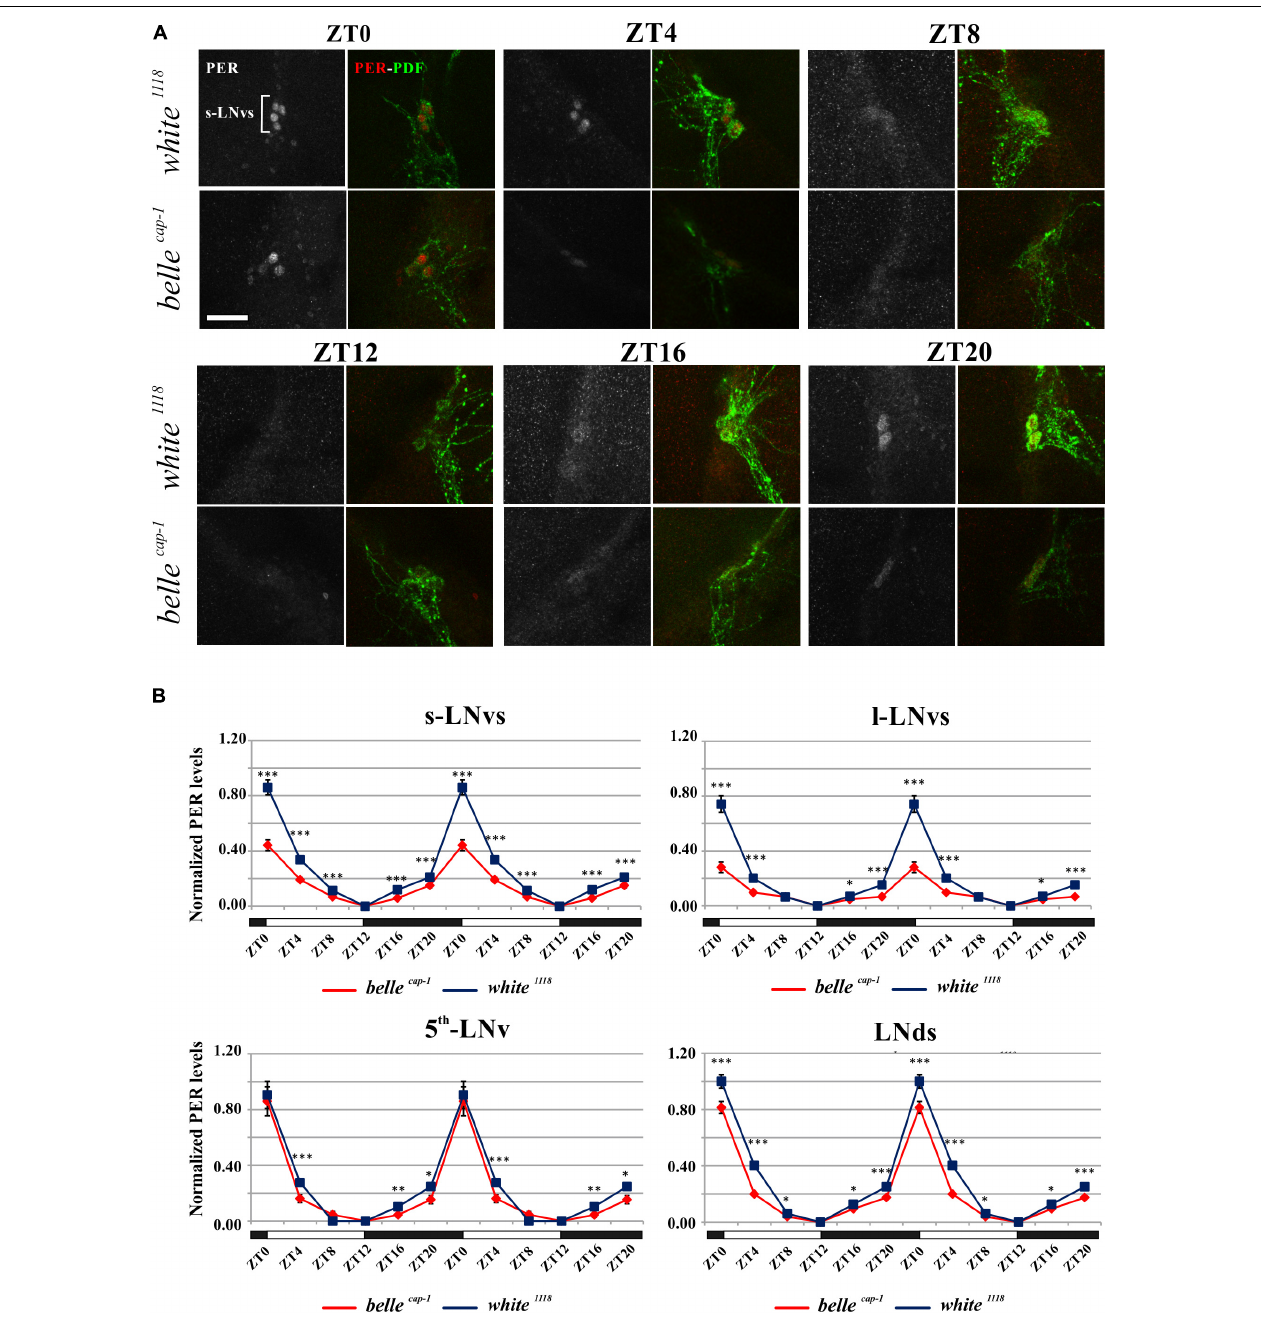
FIGURE 6 | Altered PER expression in belle cap − 1 mutant in entrainment conditions. PER oscillations in the clock Lateral Neurons of belle cap − 1 mutant flies in LD cycles. Flies were collected at the indicated time points after 3 days in LD and stained for PER and PDF. (A) Representative confocal stack images of PER staining in s-LNvs. belle cap − 1 mutants displayed lower PER expression in circadian pacemaker neurons, compared to control ( white 1118 ). Scale bar: 25 µ m. (B) PER quantification in clock Lateral Neurons. Peak value was set to 1 and the rest of the values were normalized accordingly. Data are shown as double-plotted. t -Test: ∗∗∗ p < 0.005, ∗∗ p < 0.01, ∗ p <